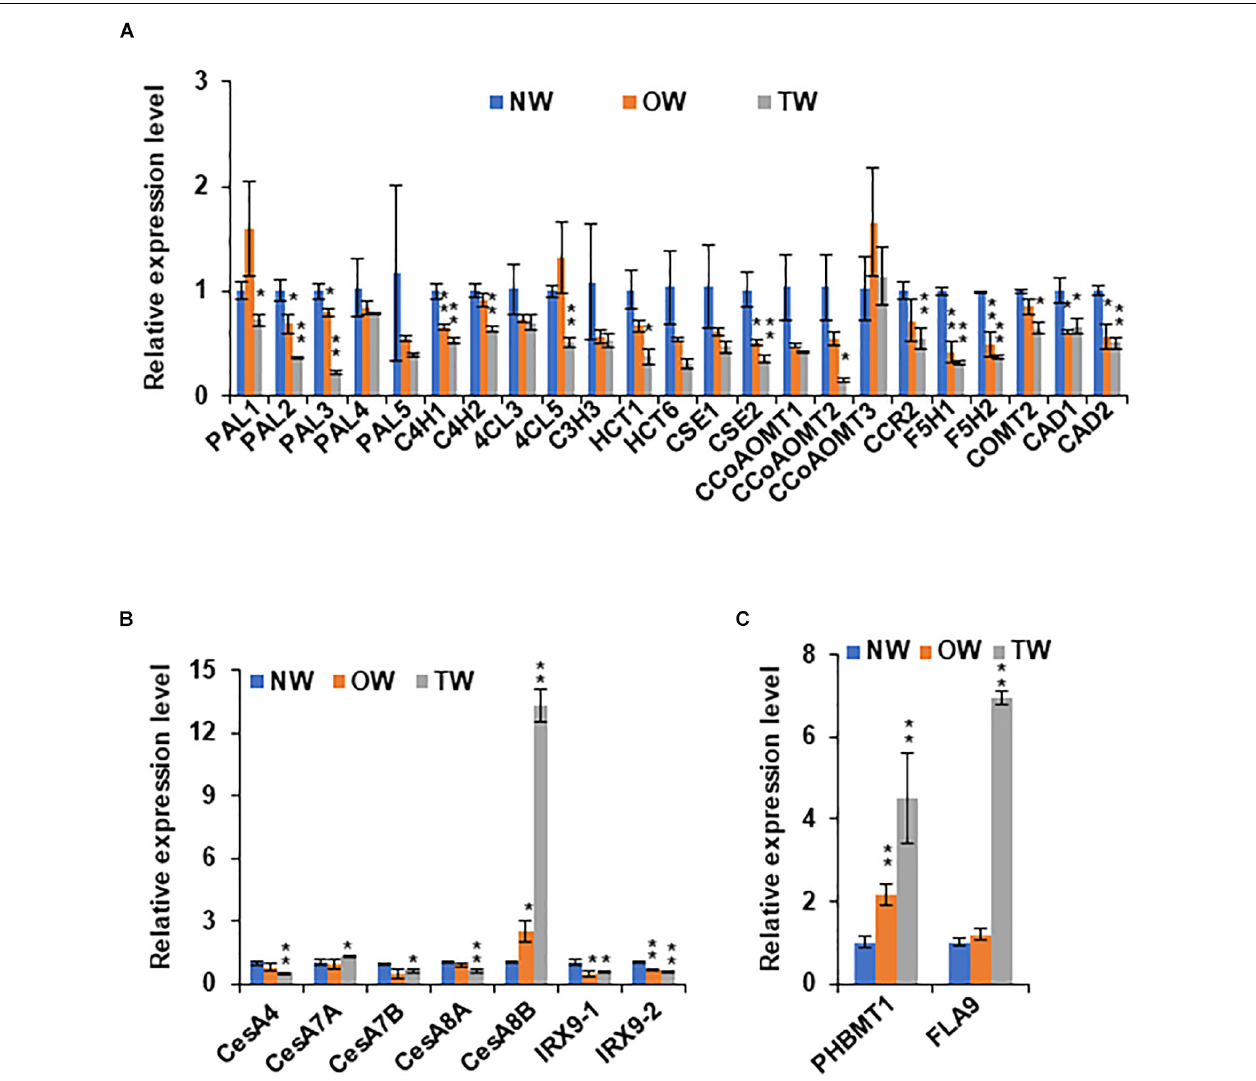
FIGURE 3 | The expression of secondary cell wall synthesis related genes in poplar stem under gravitropic stimulation. (A) Relative expression levels of monolignol biosynthetic genes in NW, OW, and TW of hybrid aspen plantlets. (B) Relative expression levels of secondary cell wall related cellulose synthase (CesA) genes and xylosyltransferase genes IRX9-1 and IRX9-2 in NW, OW, and TW of hybrid aspen plantlets. (C) Relative expression levels of PHBMT1 and FLA9 , a marker gene for TW. Gene expression in NW was set as 1. Data in (A–C) represent the mean ± SD of three biological repeats. Asterisk indicates significant difference compared with the corresponding normal wood, * P < 0.05, ** P < 0.01 (Student’s t